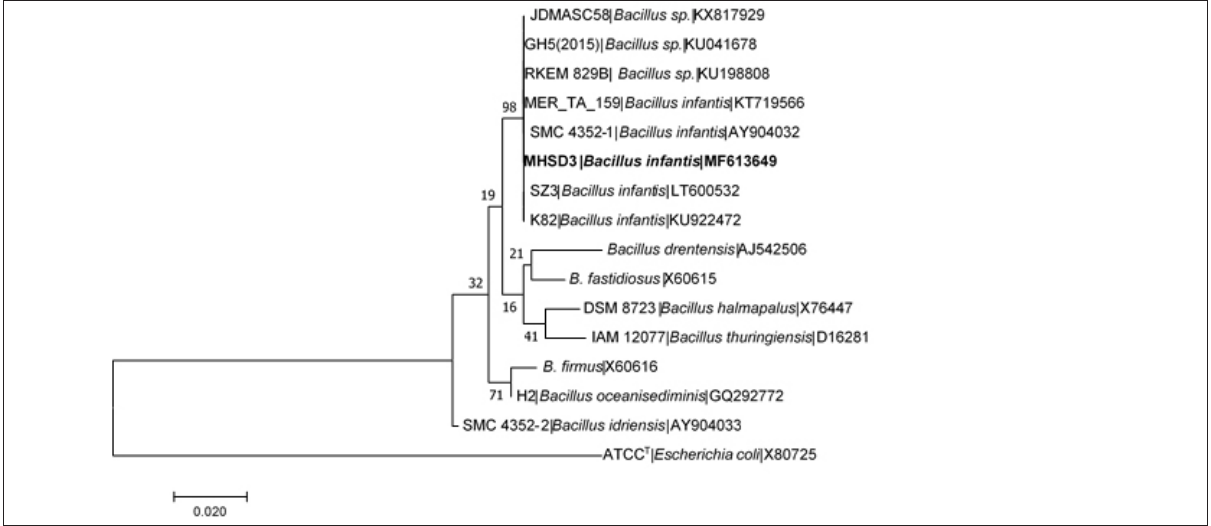
Figure 3: Maximum likelihood tree based on the 16S rRNA gene sequences of Bacillus infantis strain MHSD3 and its closest phylogenetic neighbours. The numbers on nodes indicate bootstrap values after 1000 replicates expressed in percentages. Escherichia coli strain ATCC X80725 was included as an outgroup. T indicates type